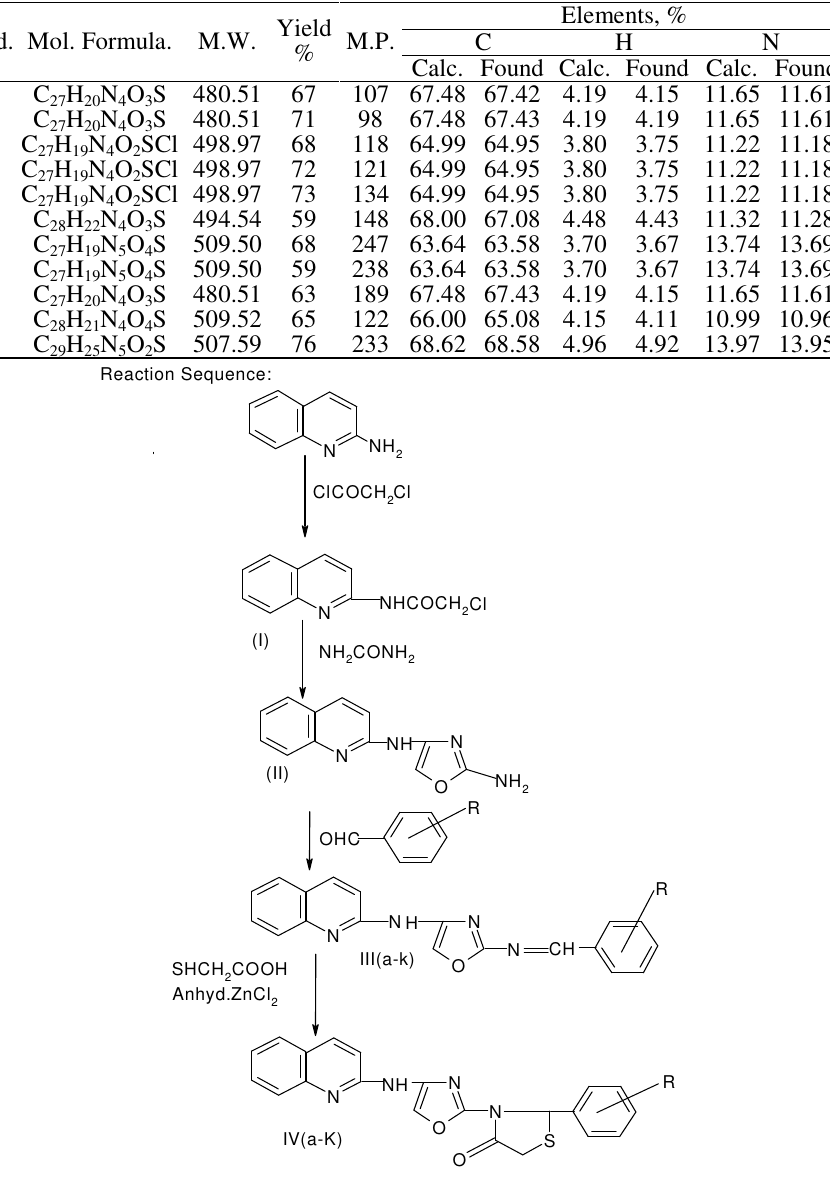
Table 2. Physical characterization data synthesized compound IV(a k)